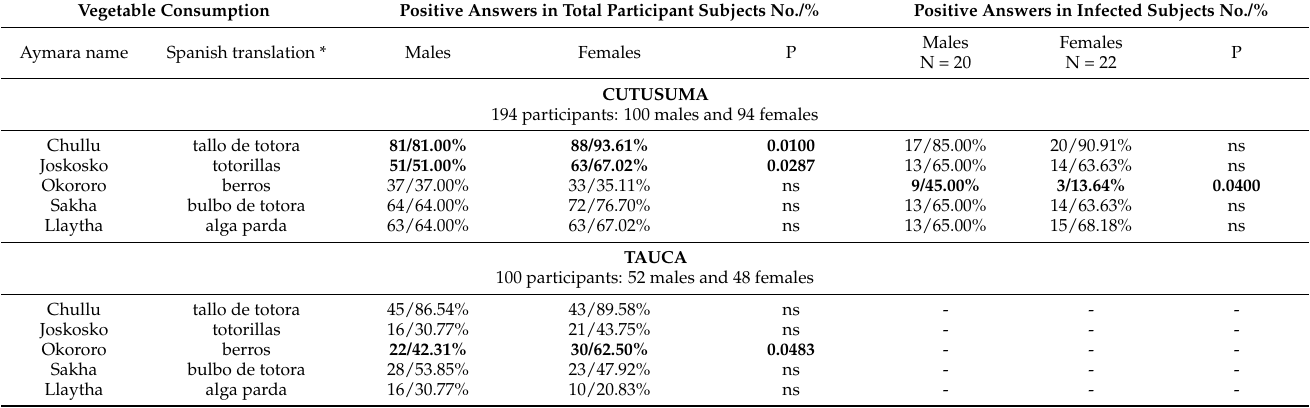
* = for corresponding species names see Table 1. ns = not